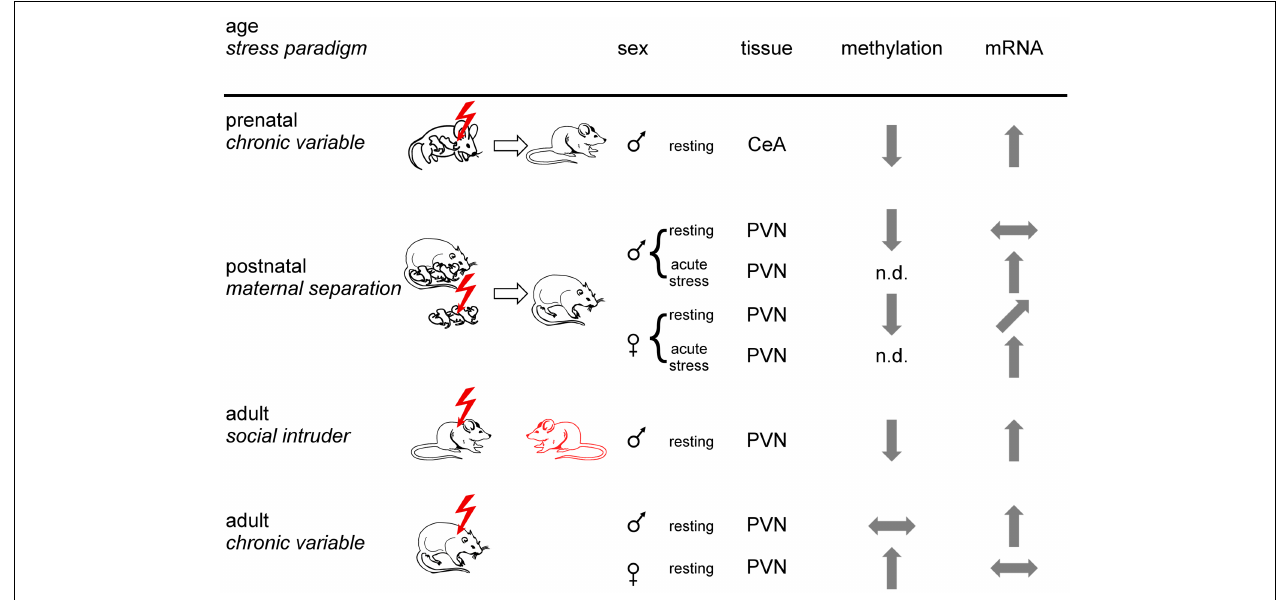
were isolated under resting conditions or following application of an acute stressor. Arrows show increased, decreased, and unaltered CpG methylation and Crh mRNA expression, respectively, for the indicated brain regions. Non-determined (n.d.) refers to the absence of information. In sum, epigenetic programing of C rh occurs in a stressor-, sex-, and tissue-specific